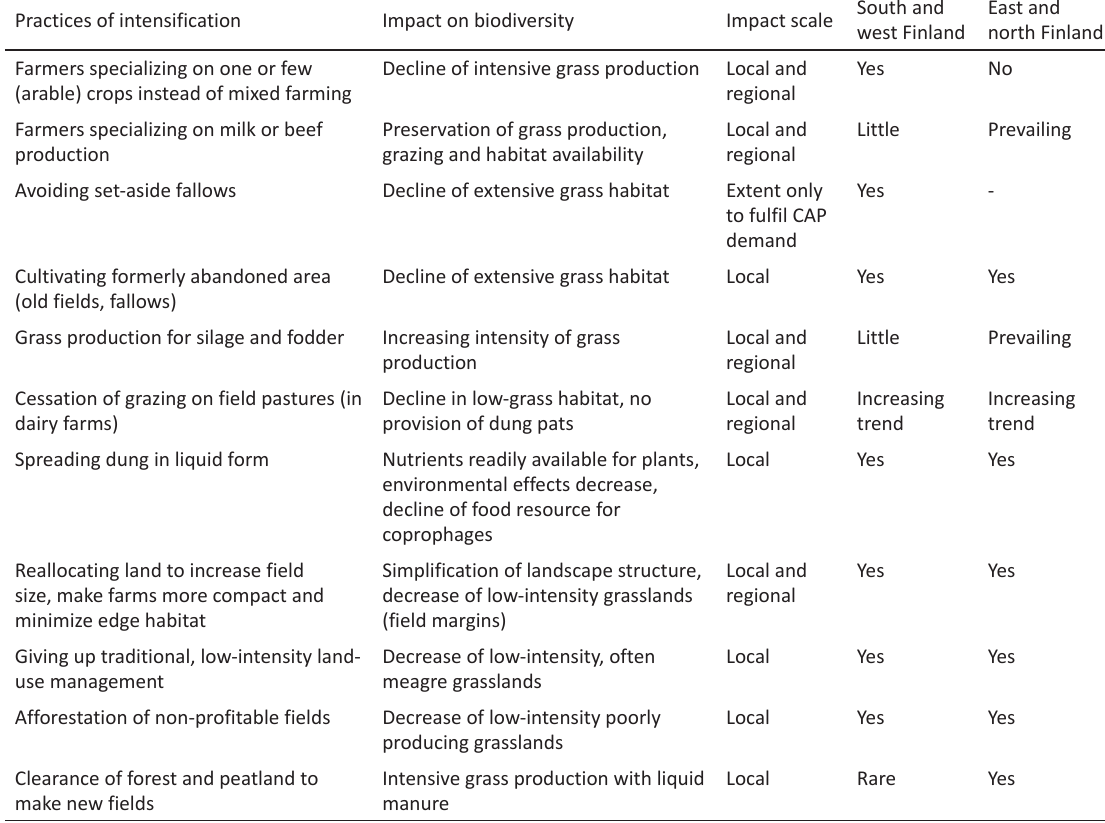
Table 1. Practices of agricultural intensification on local (farm and landscape) and regional scales. Practices of